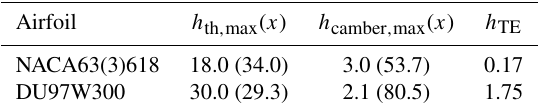
Table 2. Maximum thickness, maximum camber and trailing-edge thickness. Chord position in brackets. All values in % c